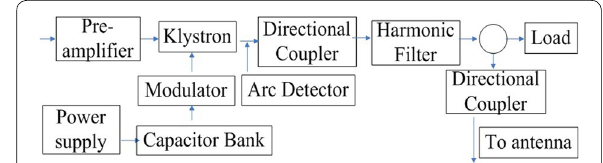
Fig. 5 Schematic diagram of the transmitter RF